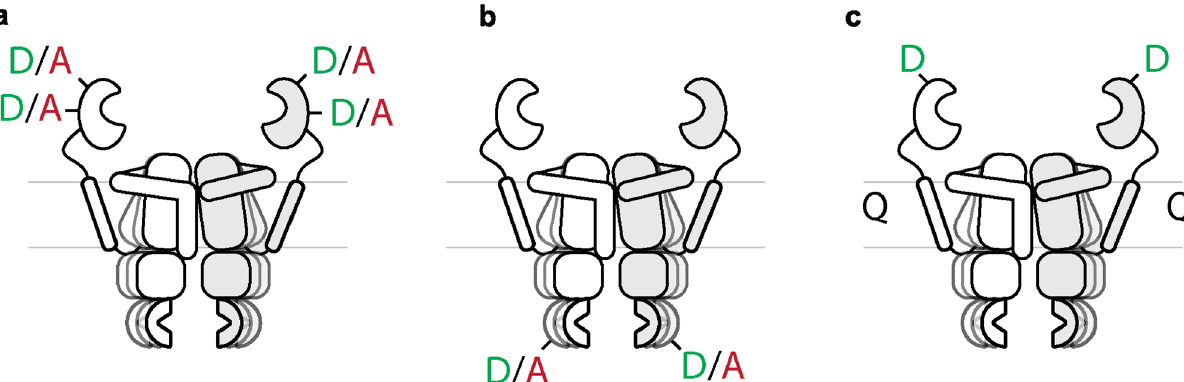
Figure 5. ( a ) Stochastic labeling of a homodimer with 2 cysteine residues per protomer, leading to 2 4 possible species. ( b ) Stochastic labeling of a homodimer with one cysteine residue per protomer to probe inter-protomer distances. 2 2 possible species (because the twofold symmetry, both DA and AD species, thus 50% of all species, are available for FRET) ( c ) Labeling of a single cysteine residue per protomer with a fluorescence donor, a fluorescence quencher is added to the lipid